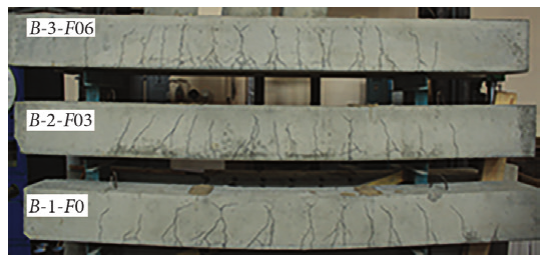
Fig. 8. The final crack pattern of the full-scale